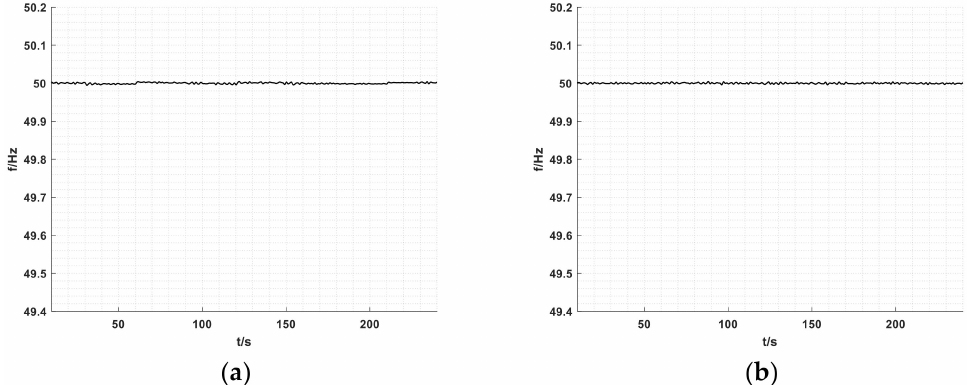
Figure 15. Influence of the wind-photovoltaic-energy storage output on frequency. Influence of the wind-photovoltaic-energy storage output on frequency. ( a ) When wind-photovoltaic-energy storage output fluctuates relatively violently. ( b ) When wind-photovoltaic-energy storage output fluctuates relatively